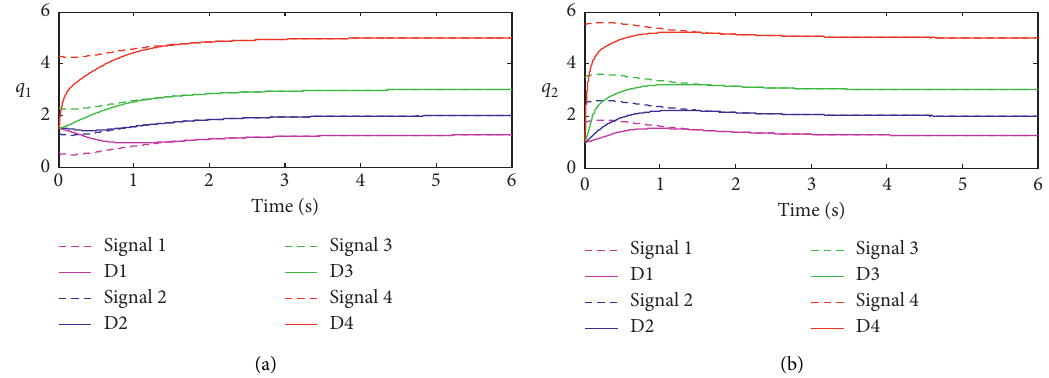
Figure 5: Position tracking performance with different desired signals.